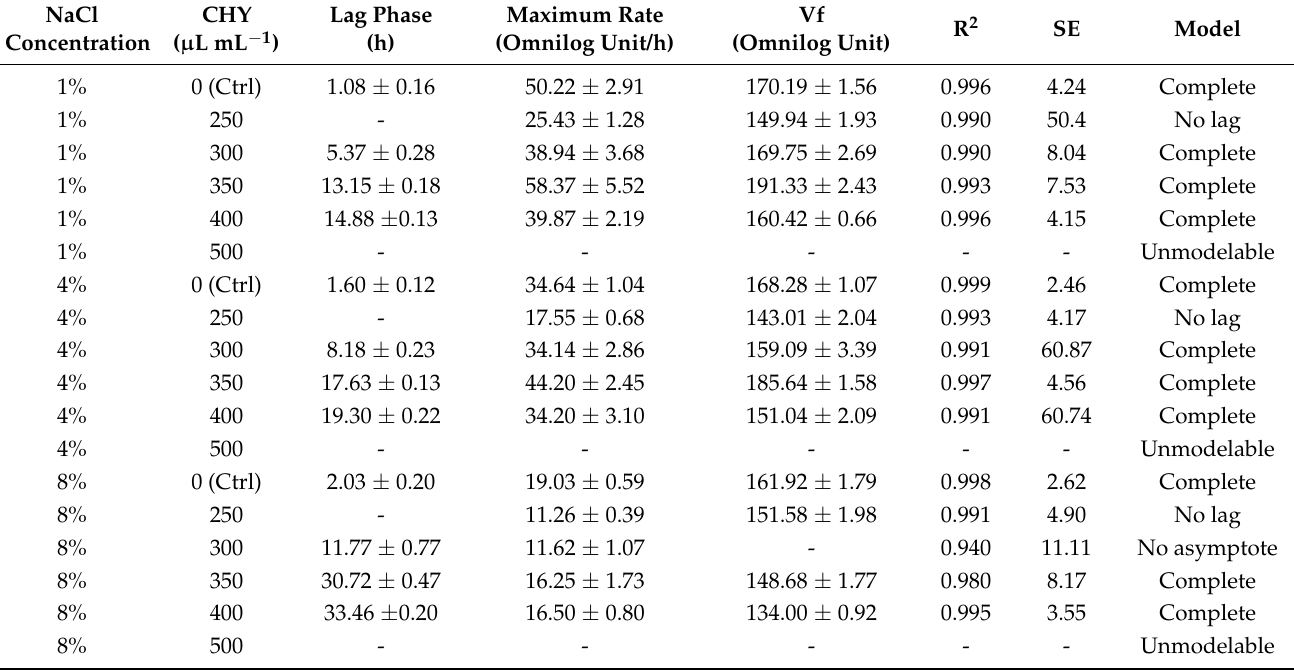
Table 2. Growth parameters of L. monocytogenes ATCC 7644 cells, previously exposed to increasing CHY concentrations, in presence of 1 (well B10), 4 (B11) and 8 (B12) % NaCl concentration. Results are obtained from the Baranyi and Roberts model. The table displays: Lag phase (h), Maximum growth rate (Omnilog unit/h) the final (Vf) cell density value (Omnilog unit), the R-squared (R 2 ), the standard error (SE) and the assessment of the fitting model